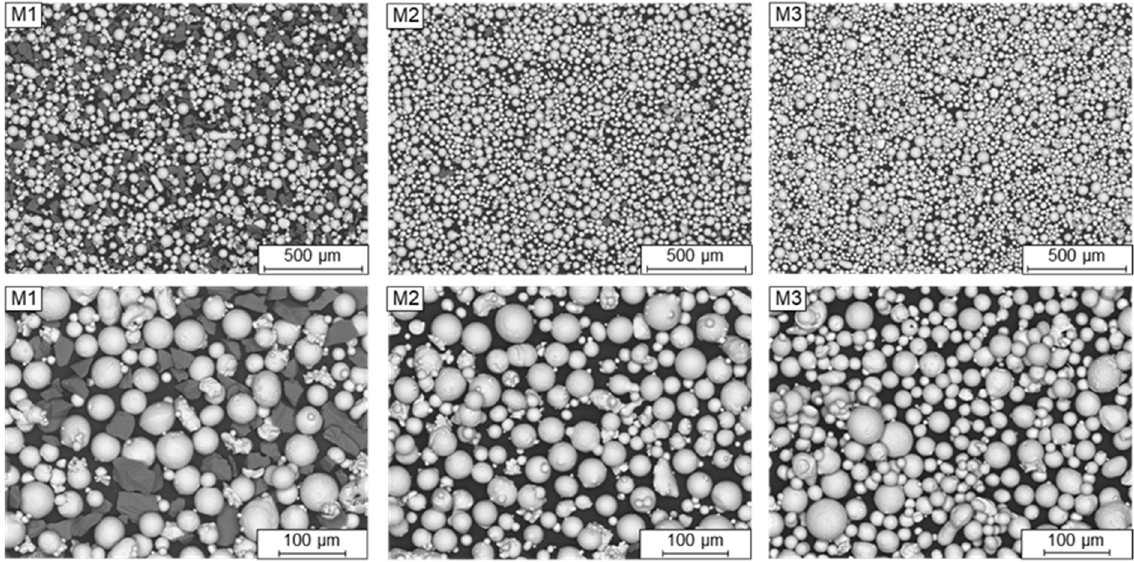
Figure 1. SEM (scanning electron microscope) powder morphology (left: M1, middle: M2, right: M3).